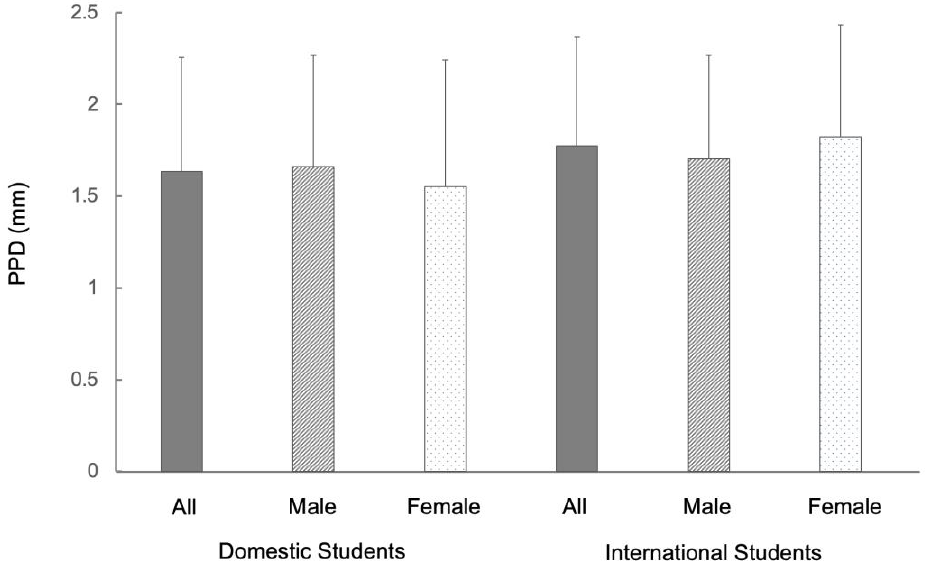
Figure 4. Differences in probing pocket depth (PPD) status between international and domestic students in Japan. Note: The mean PPD of international students ( n = 79) was 1.77 mm and that of domestic students ( n = 152) was 1.64 mm, showing no significant difference between the two groups. Error bars denote the standard deviations of the